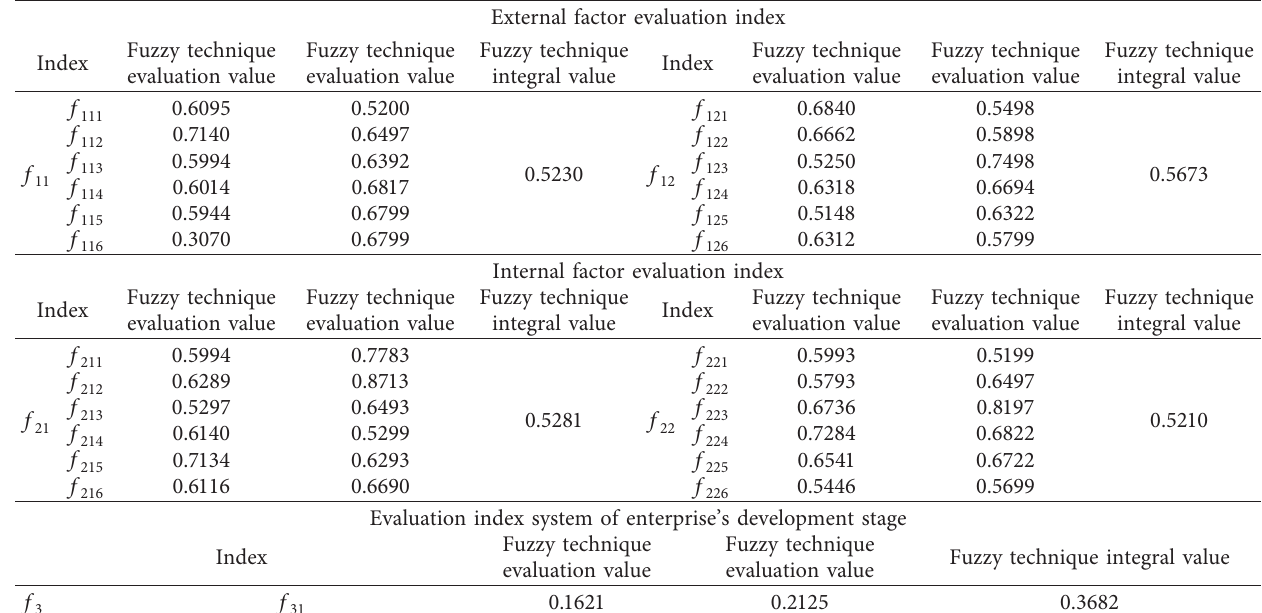
Table 3: ARR advance intelligent manufacturing-adaptive strategic path four-level index and fuzzy technique integral